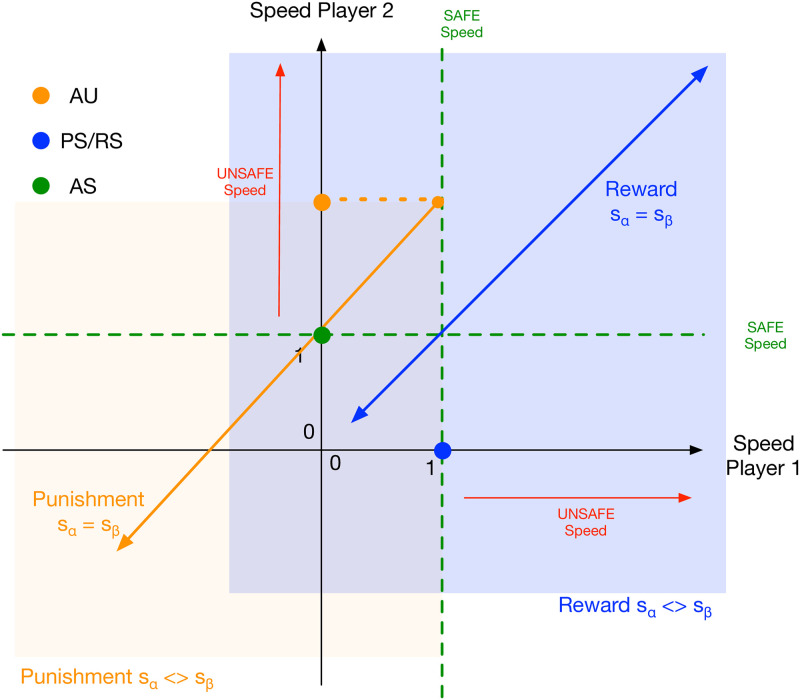
Effect of positive and negative incentives on players’ speed.On the one hand, when player 1 is of type PS (blue circle on x-axis), i.e. sanctioning unsafe actions, it reduces the future speed of player 2 when she is of type AU (orange circle on the y-axis), while paying a speed cost, possibly equivalent to the reduction in speed that the AU player is experiencing (orange line). In general the reduction of speeds of player 1 and 2 fall into the area marked by the orange rectangle (it is referred in the main text as orange area). On the other hand, when player 1 is of type RS (blue circle on x-axis), i.e. rewarding safe actions, it increases the speed of player 2 (green circle on y-axis), while paying a speed cost that reduces the RS player’s speed. Differently from before, the speed effect is in opposing directions for the two players (hence, the blue line is bidirectional). The blue rectangle (referred in the main text as blue area) marks the area of the speed of player 1 and player 2. In the analysis in the paper, first the case of equal speed effects is considered (lines) before analysing different speed effects (rectangles) between both players.